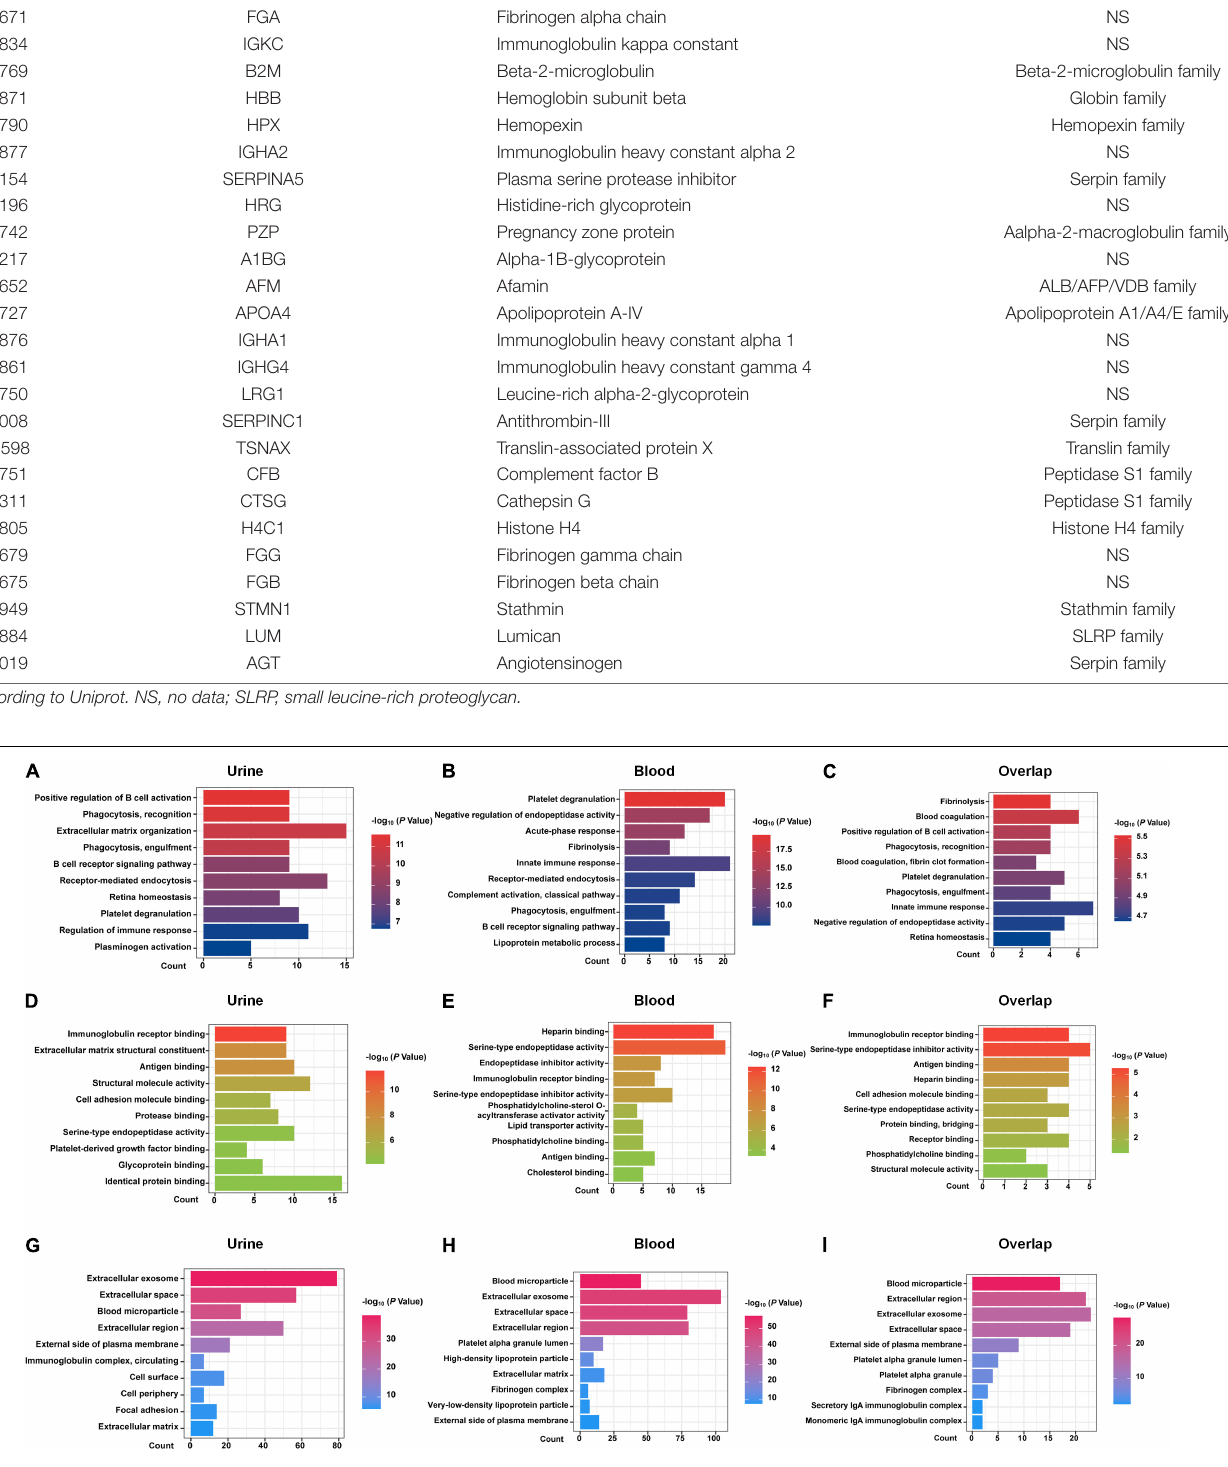
FIGURE 1 | GO analysis with DAVID. GO analysis of the DEPs of urine samples, blood samples, and 25 shared DEPs based on proteomics studies are shown. (A–C) biological process (BP) items. (D–F) molecular function (MF) items. (G–I) cellular component (CC) items.